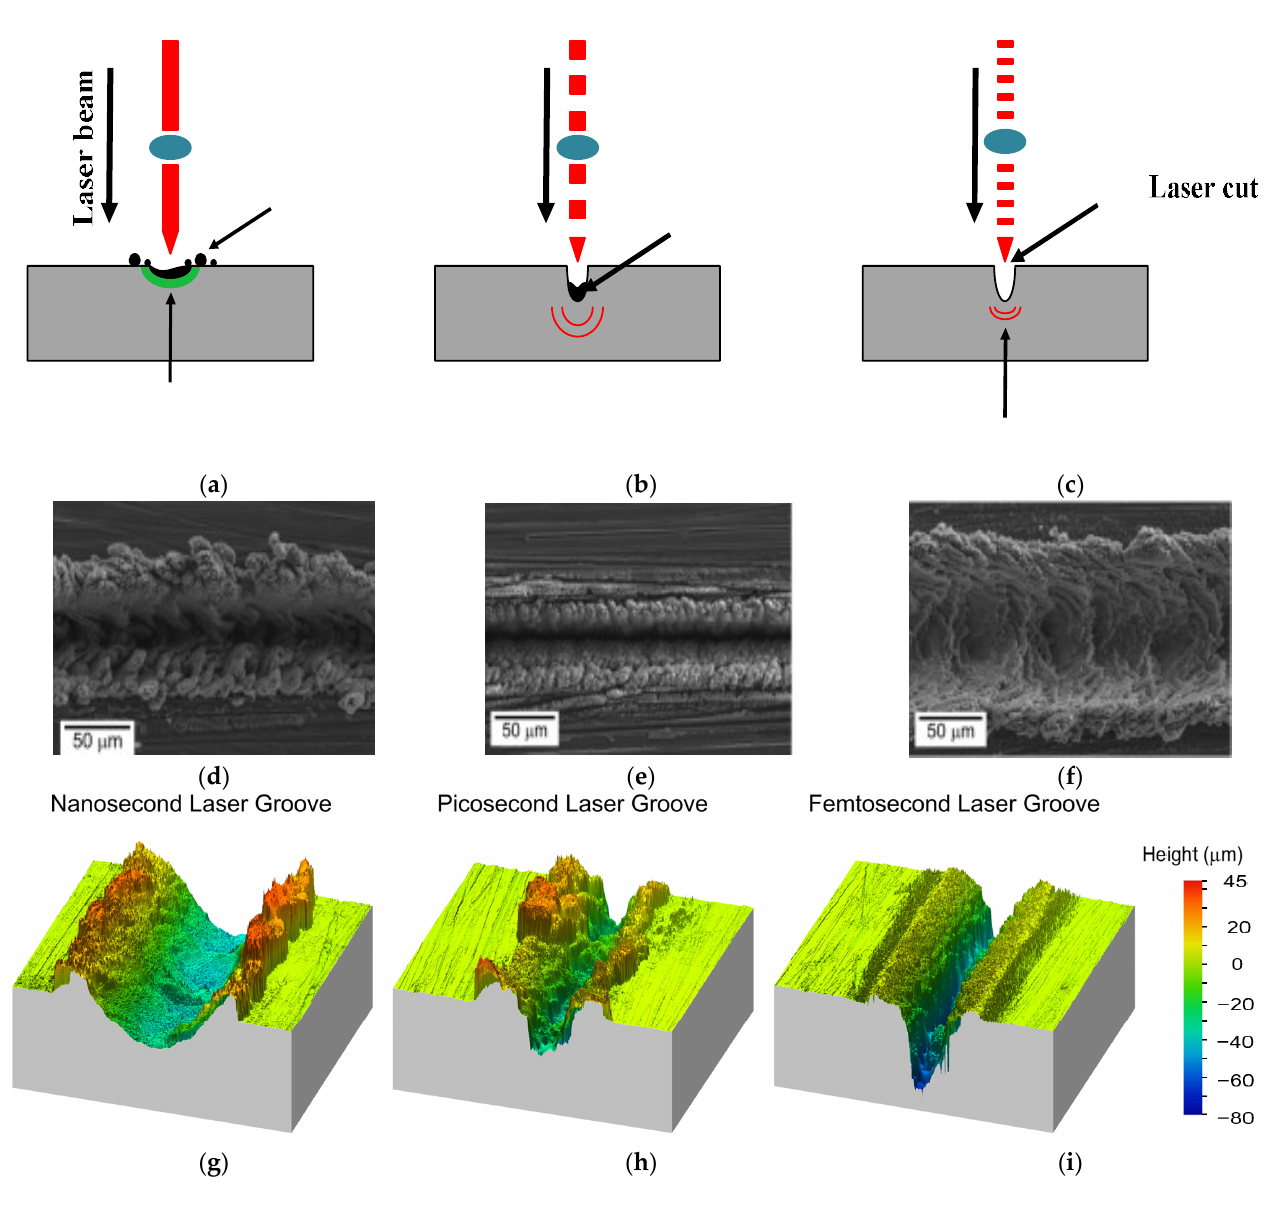
Figure 2. Classification of lasers based on pulse durations: ( a ) long pulse, ( b ) short pulse, and ( c ) ultra-short pulse; SEM images of surface morphology with: ( d ) ns laser, ( e ) ps laser, and ( f ) fs laser; surface texture cross-section profiles generated with: ( g ) ns laser, ( h ) ps laser, and ( i ) fs laser, Reprinted with permission from [46]. Copyright from Elsevier 2021.